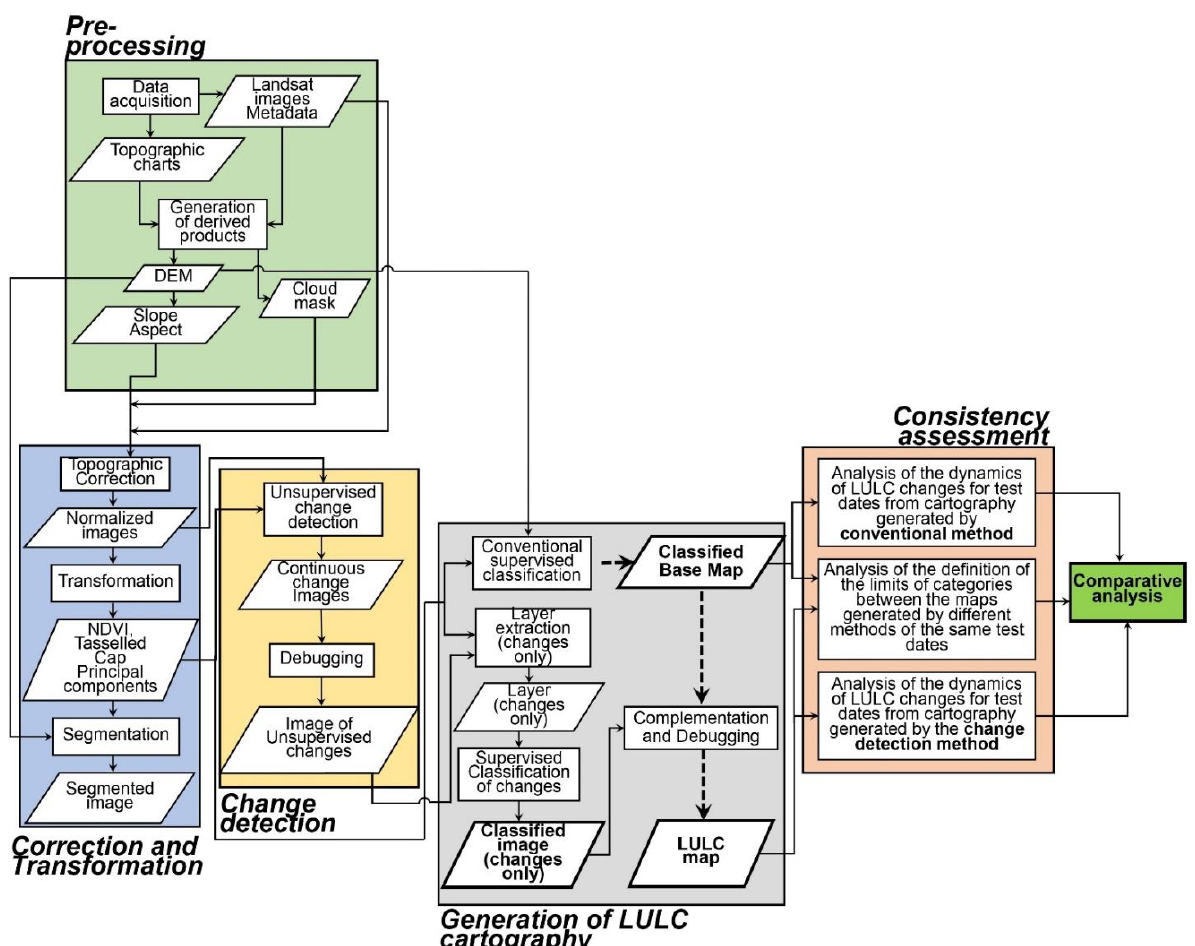
Figure 3. General flowchart of the proposed methodology. Table 1. Definition of the legend’s categories of LULC for the performance of the classification